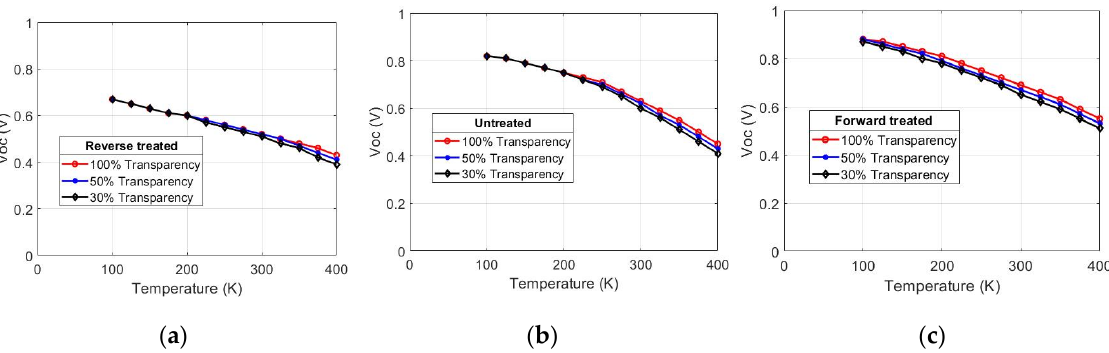
Figure 3. Open-circuit voltage (Voc) vs. temperature plot. In ( a ), the sample treated with a reverse bias. In ( b ) the non-treated sample. In ( c ), the sample treated with a forward bias. In all three cases, the Voc is plotted for each illumination level according to the transparency of the optical filter.